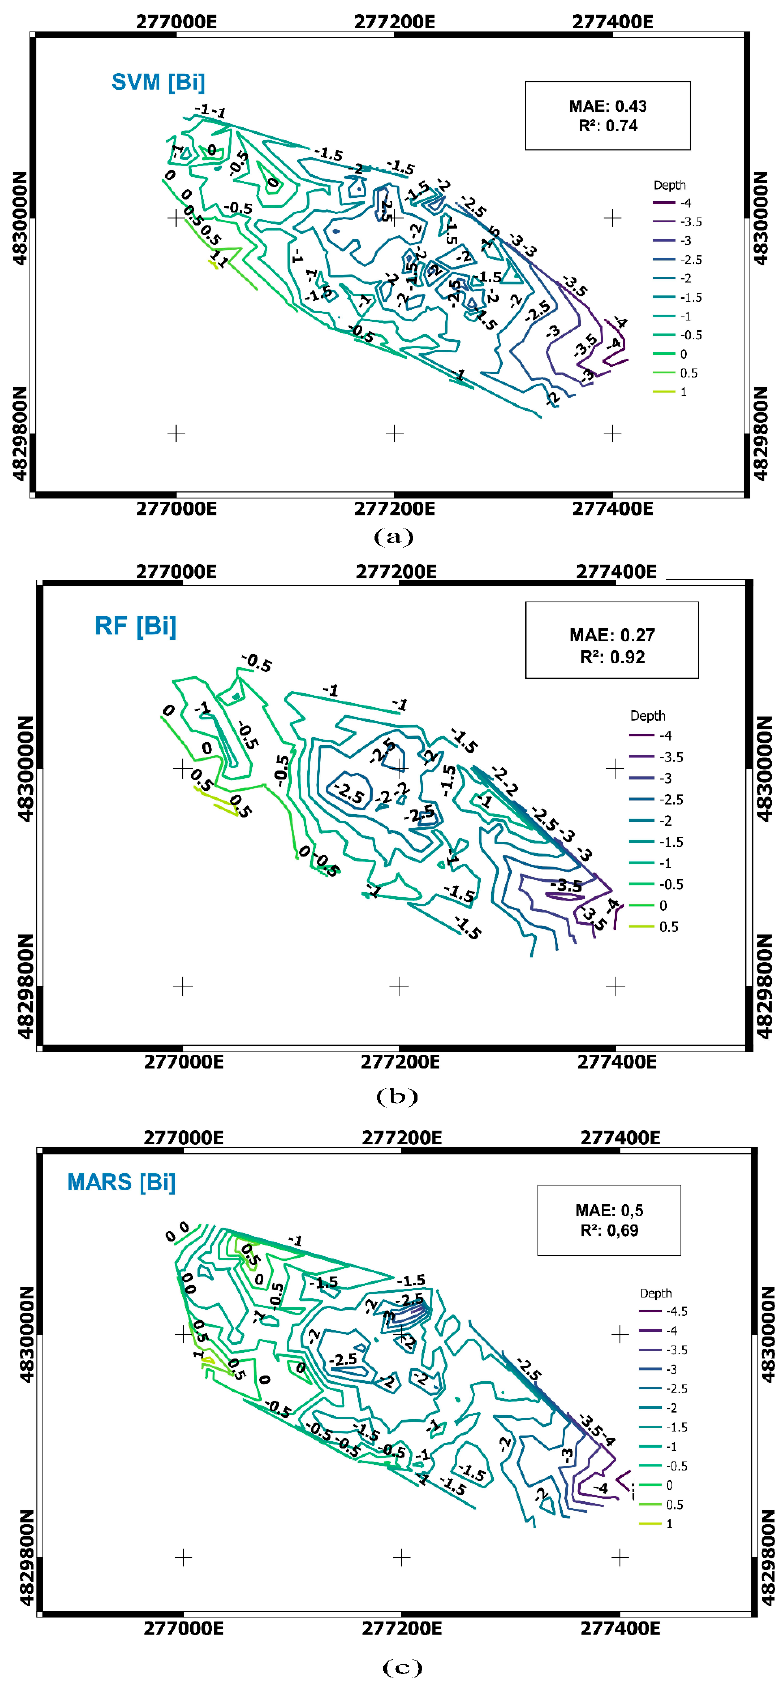
Figure 7. Comparison of water depth maps of Candás obtained using different algorithms ( a ) SVM, ( b ) RF and ( c ) MARS, using ratios bands as input variables. The color indicates the depth in meters.